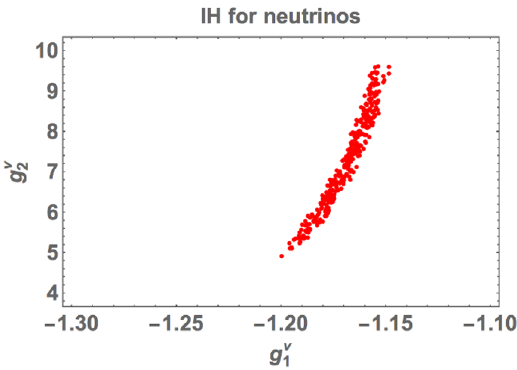
Figure 7 . Allowed regions of τ for IH. Red corresponds to 5 σ confidence level.